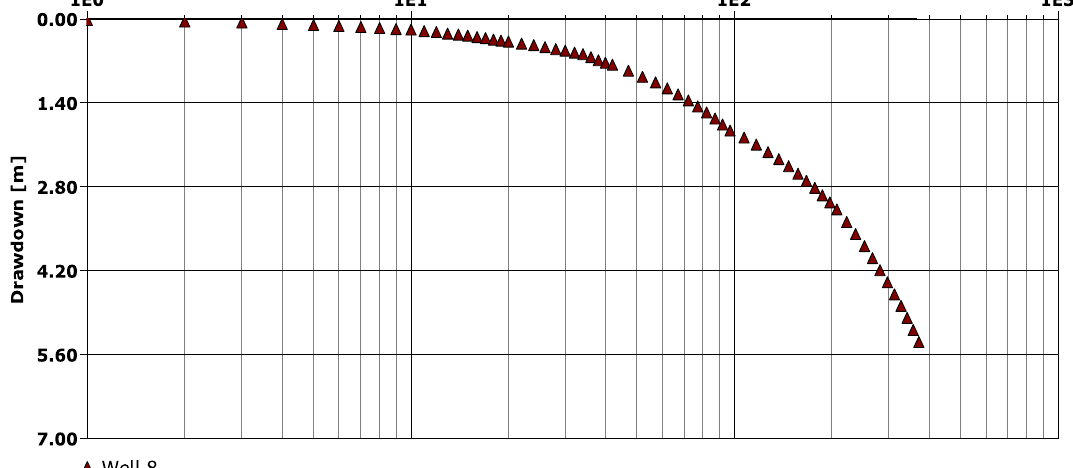
Fig. 25 Theis’s method of pumping well-8